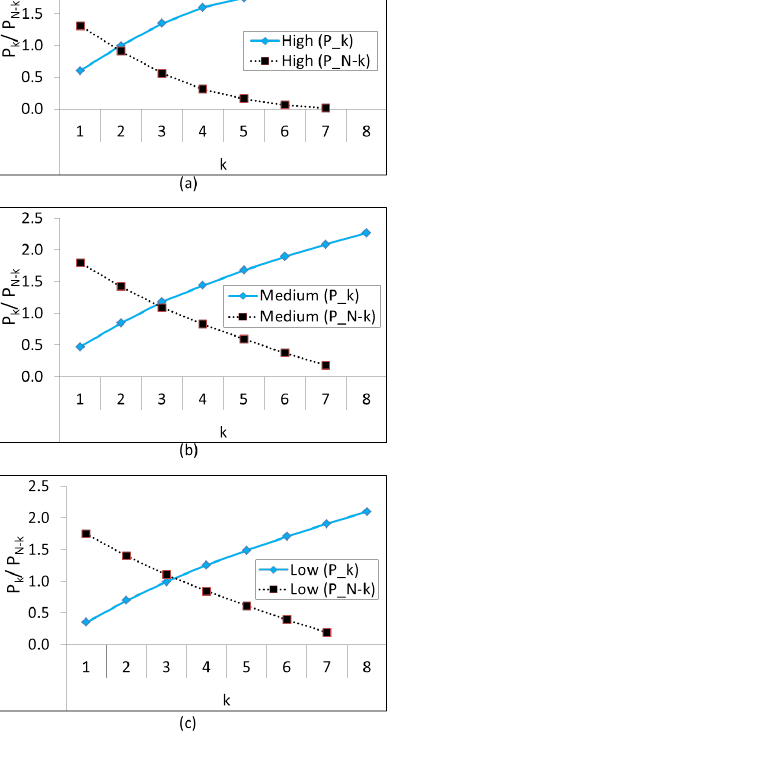
Figure 6. Simulation of proposed algorithm for High , Medium and low cases. ( a ): Simulation result for ’High’ case. ( b ): Simulation result for ’Medium’ case. ( c ): Simulation result for ’Low’